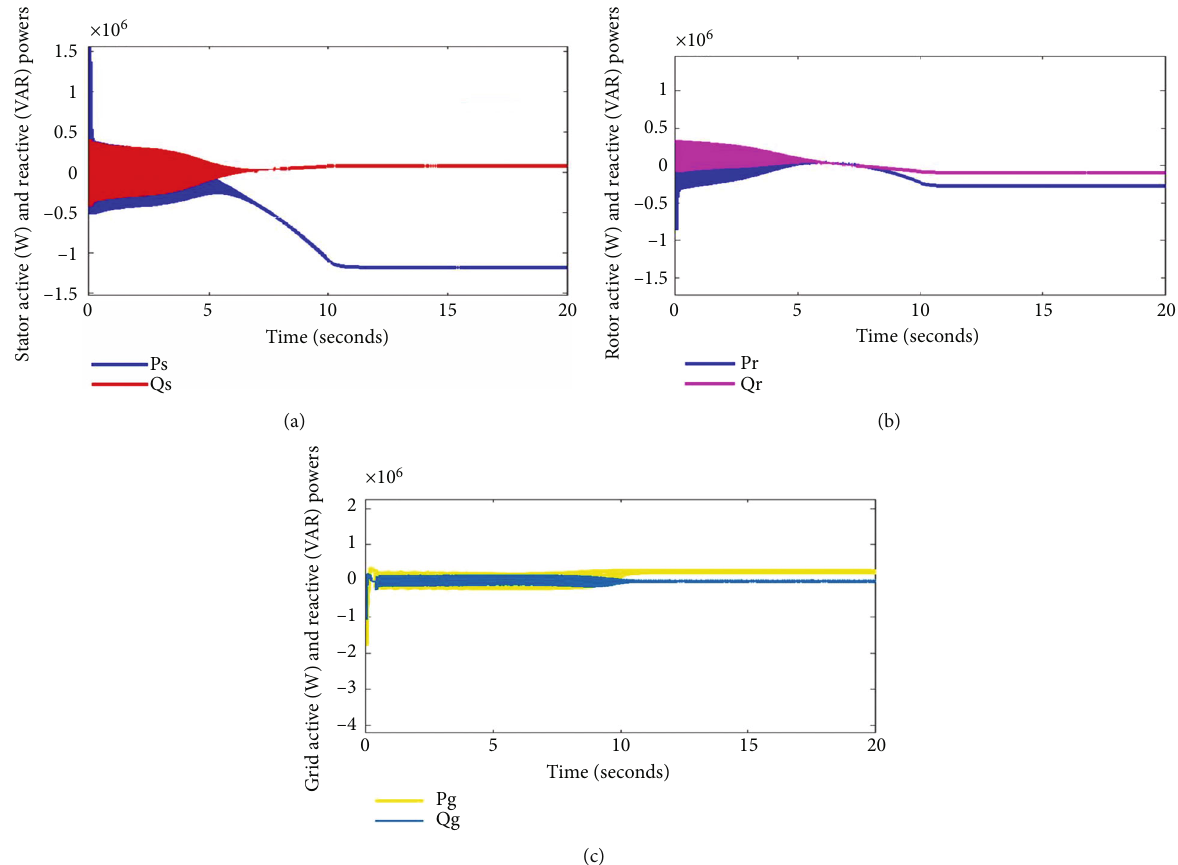
Figure 13: (a – c) Stator, rotor, and grid active and reactive powers using a PI